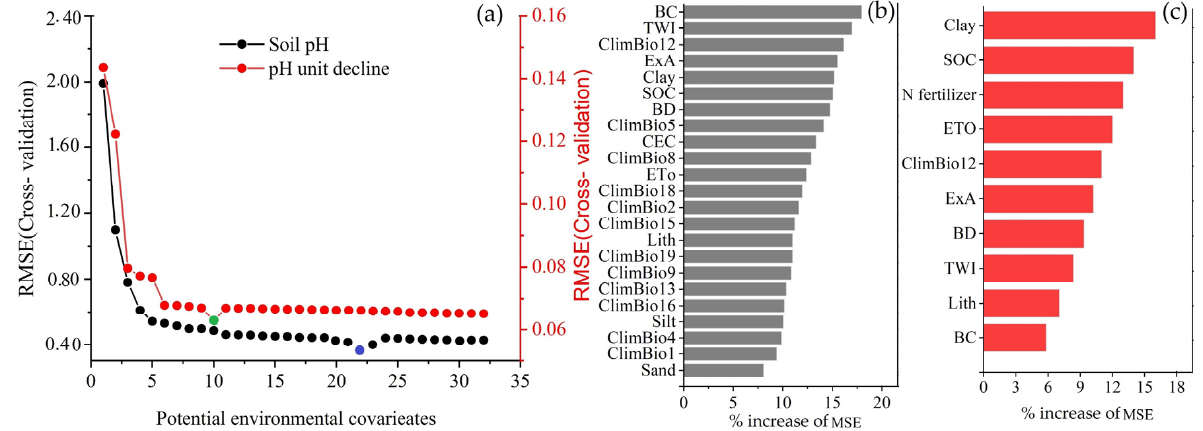
Figure 4. Covariates selected by recursive feature elimination ( a ), relative importance results for soil pH prediction ( b ), and relative importance results for soil pH decline prediction ( c ). Blue and green in ( a ) show the optimum number of covariates selected for modeling the soil pH decline and soil pH variation used in the spatial predictions.